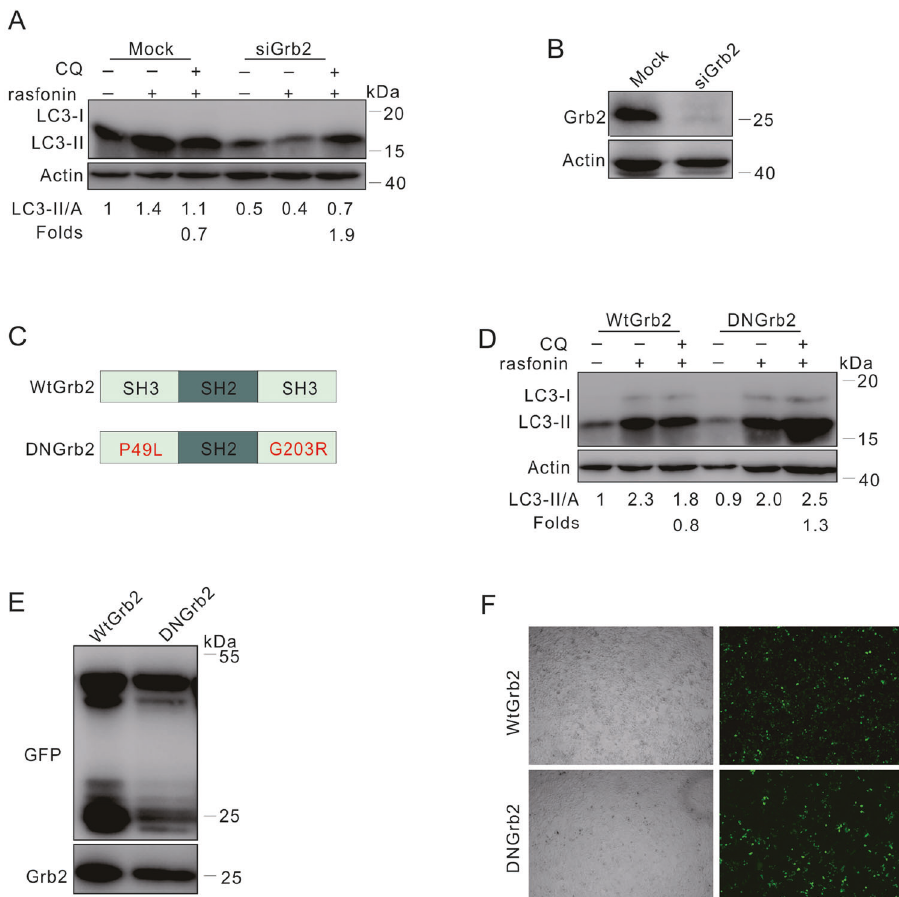
Fig. 6 Rasfonin failed to inhibit autophagy in Grb2-depleted cells. A Following transfection with the control (Mock) or Grb2 siRNA (siGrb2) for 48 h, ACHN cells were treated with rasfonin (12 μ M) for 4 h. Cell lysates were analyzed by immunoblotting with the indicated antibodies. B The ef fi ciency of siRNA interference was determined with sample in ( A ). C Schematic representation of the WT Grb2 and mutant DN Grb2. D , E HEK293T cells were transfected transiently with the WT Grb2 or DN Grb2 plasmids for 36 h, and treated with rasfonin (12 μ M) for 4 h. Cell lysates were analyzed by immunoblotting with the indicated antibody. Actin was used as a loading control. F The transfection ef fi ciency was detected and acquired by using fl uorescence microscope. Similar experiments were repeated at least three